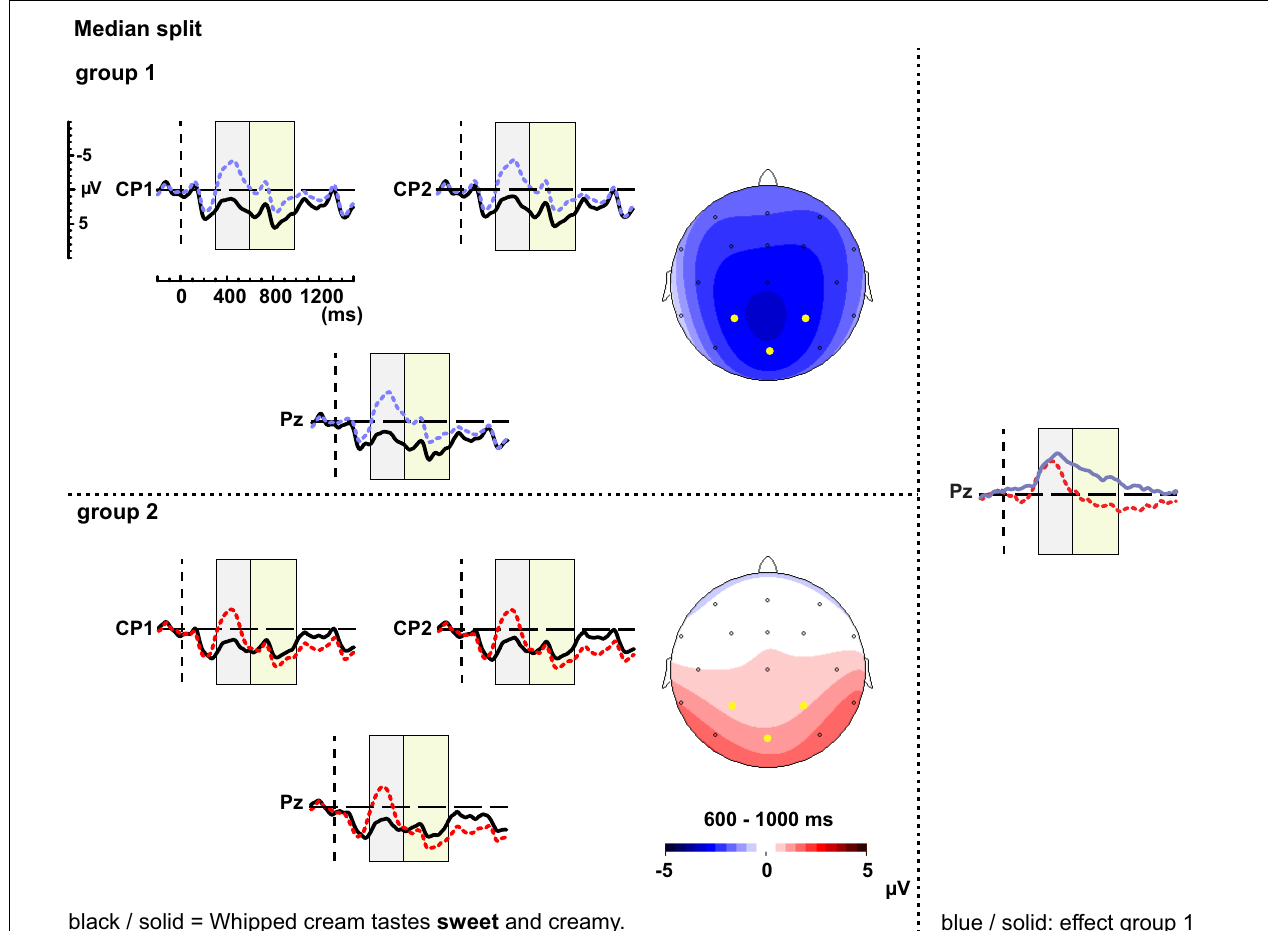
blue / solid: effect group 1 red / dashed: effect group 2 electrodes CP1, CP2, and Pz. Additionally, the scalp distribution of the effect elicited by the semantic manipulation between 600 and 1000ms is depicted. The right side displays the effect or difference waveforms of group 1 (blue, solid line) and group 2 (red, dashed line) at electrode